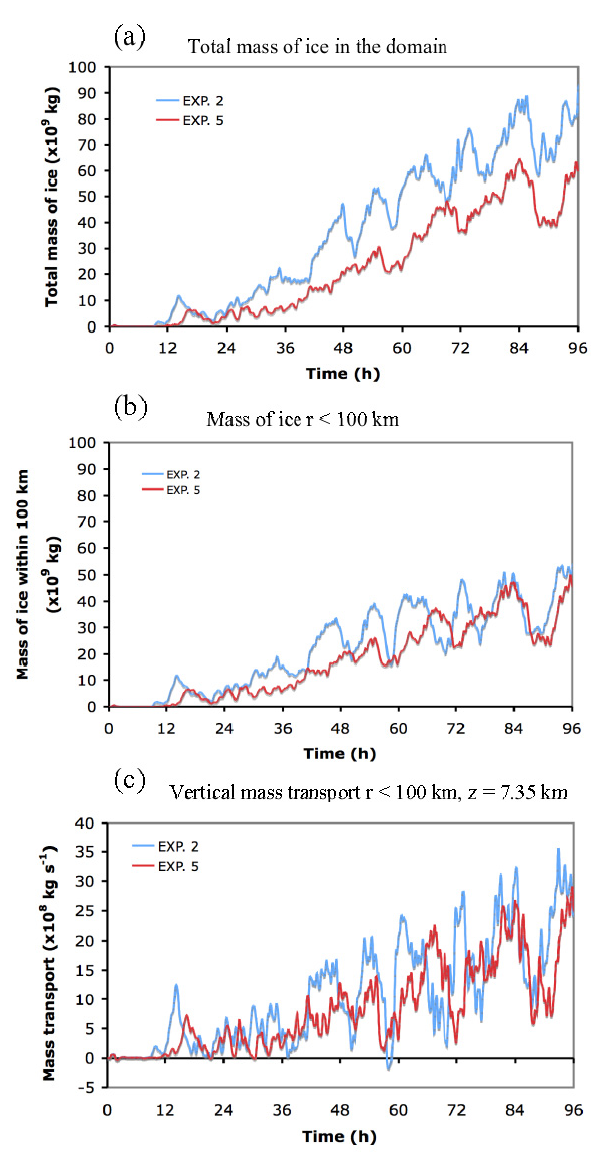
Fig. 13. Comparison of Experiments 2 and 5. (a) The total mass of ice in the fine grid domain. (b) The total mass of ice within a radius of 100 km of the center of the domain. (c) . The vertical mass trans- port of air within a radius of 100km of the center of the domain, at z = 7 . 35 km.